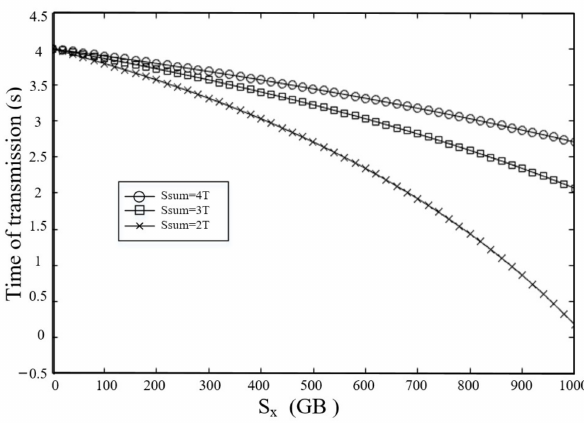
Figure 12. The relationship between C and S x at X = 4 and X = 8.